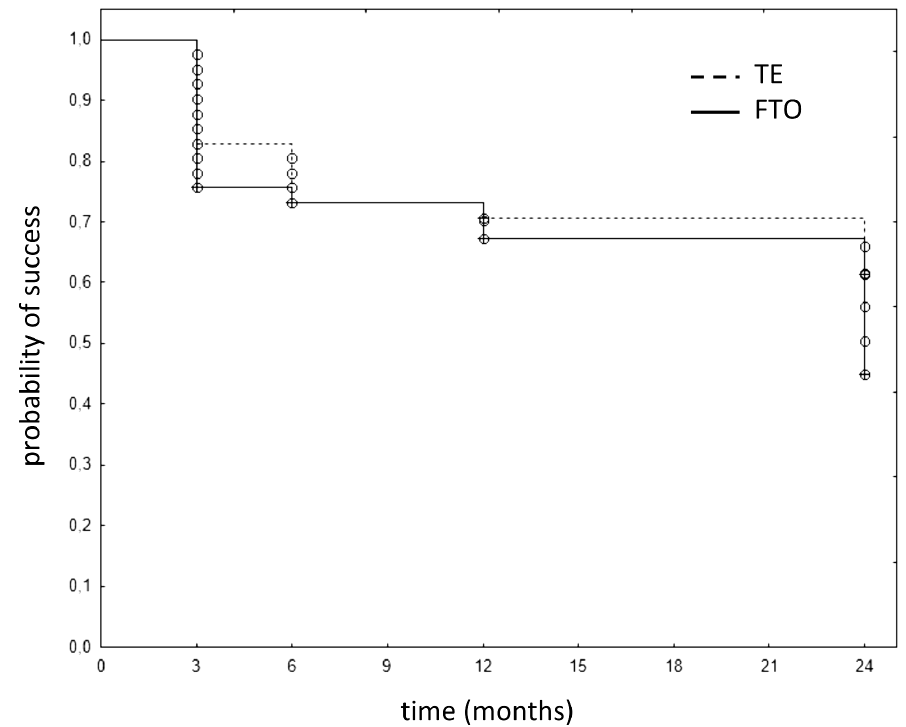
Figure 1. Kaplan-Meier curve for complete success in filtering trabeculotomy (FTO) and trabeculectomy (TE).